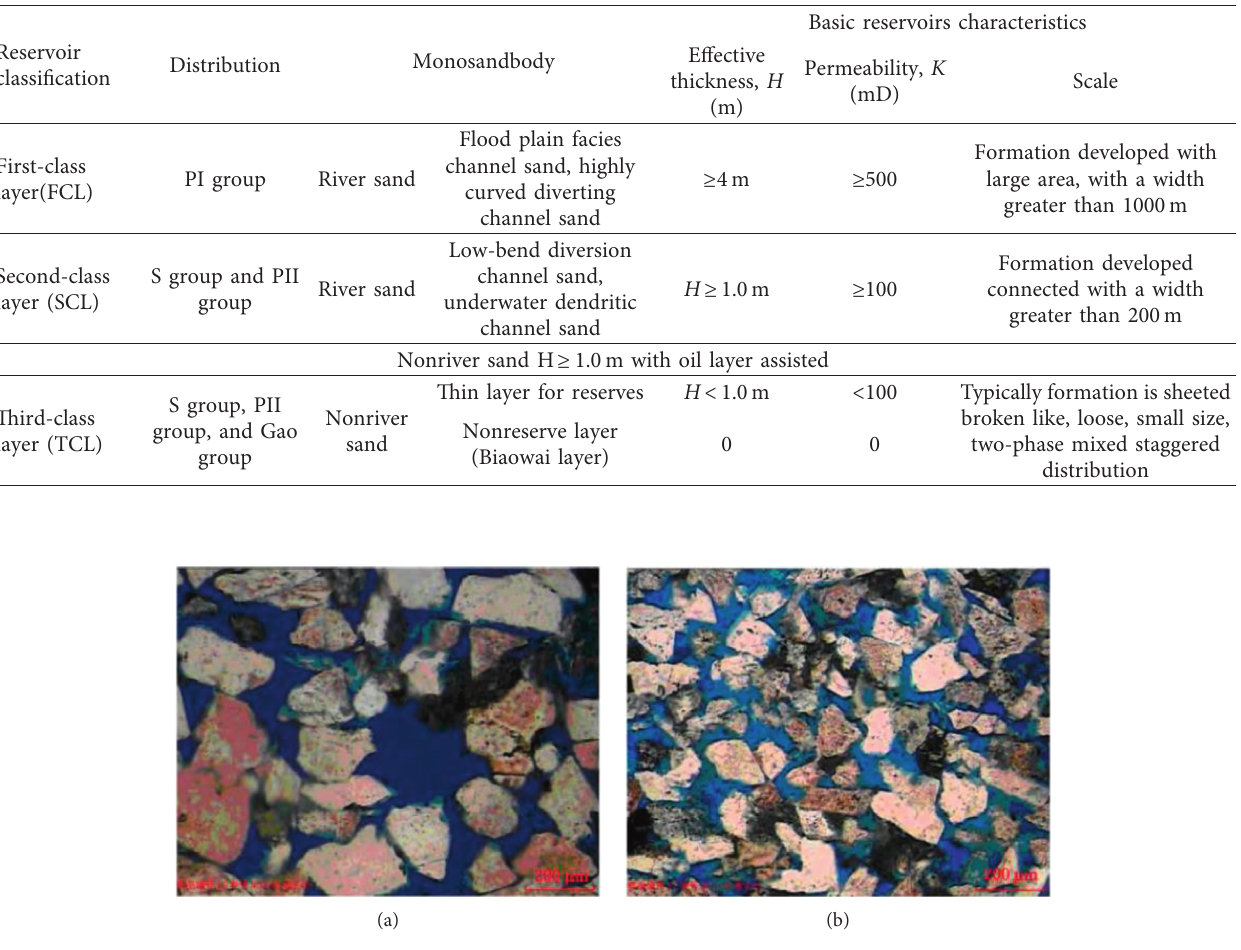
Table 2: Reservoir classification [72].